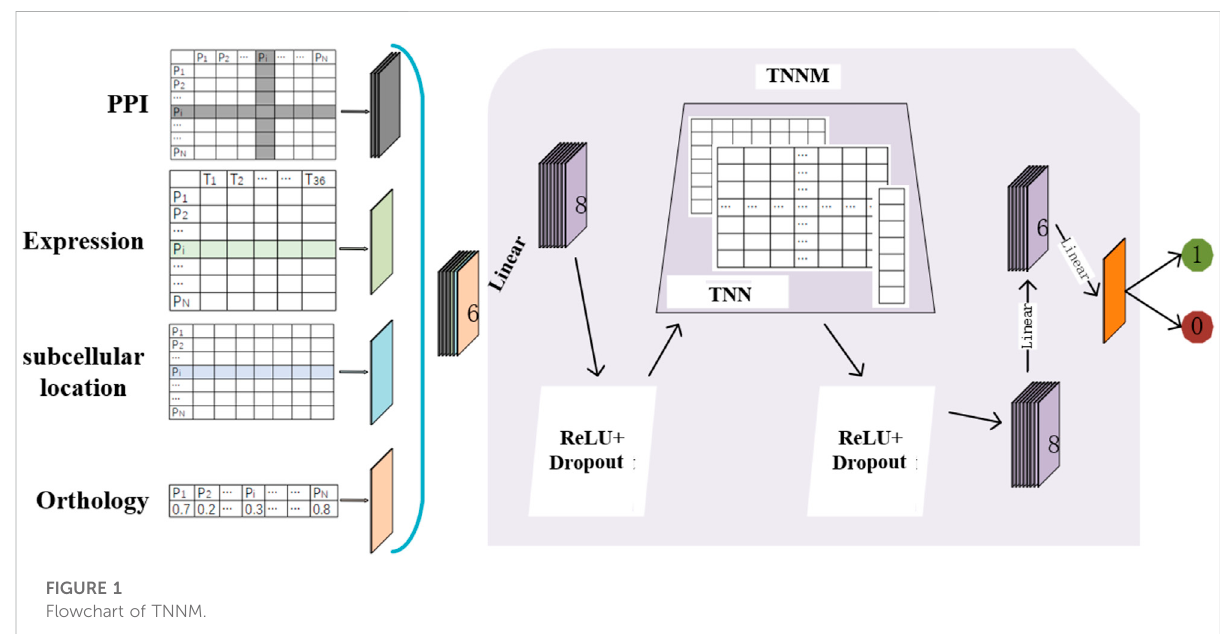
FIGURE 1 Flowchart of